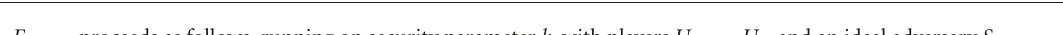
Algorithm 1: Secret sharing-based GKE ideal functionality F SS-GKE .